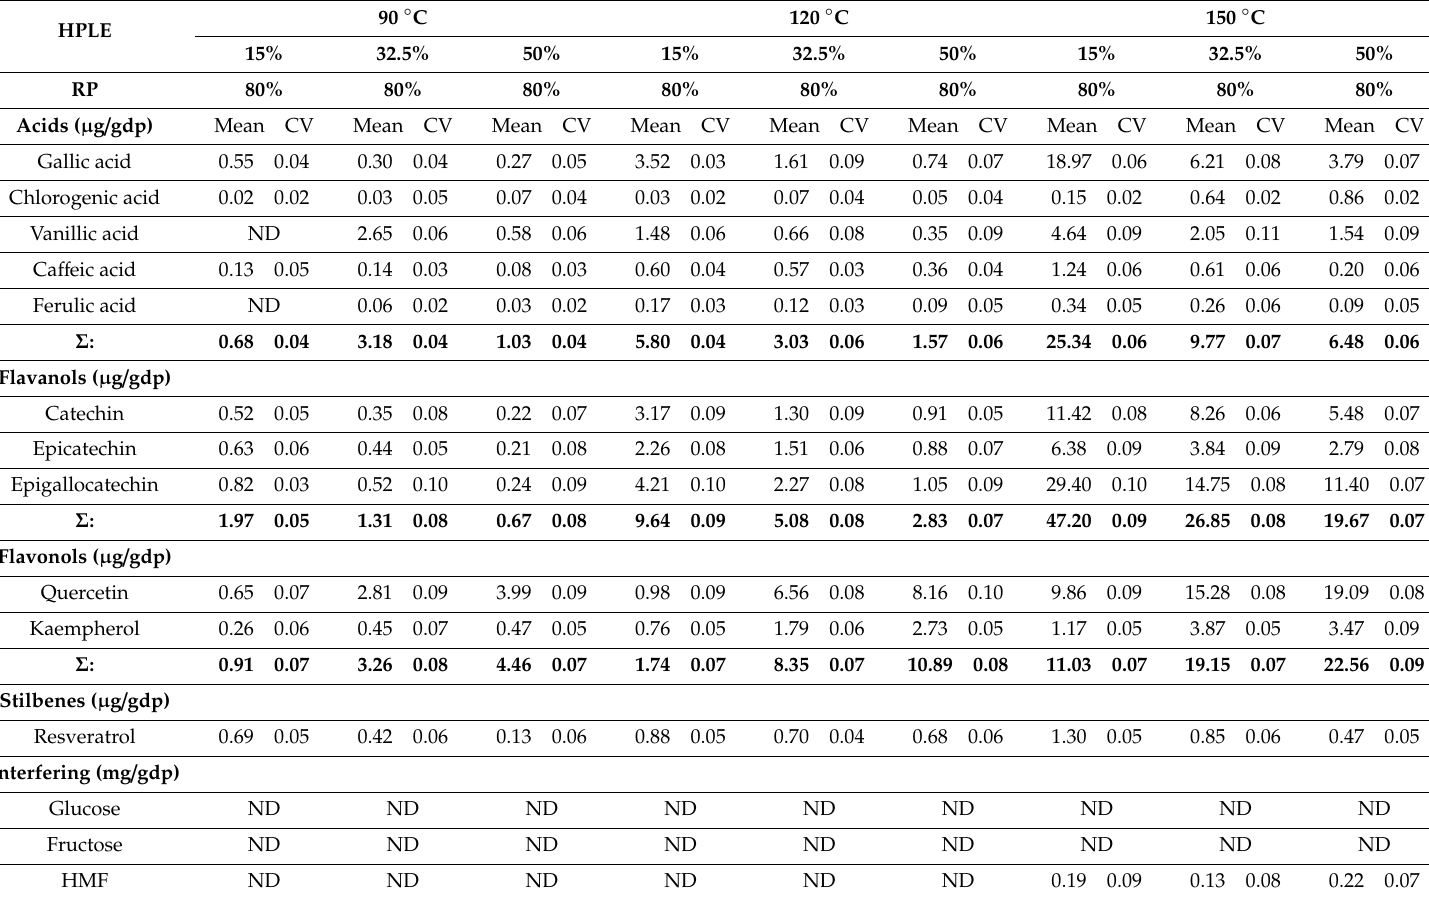
Table 4. Polyphenols profile of purified extracts obtained by integrated HPLE-RP